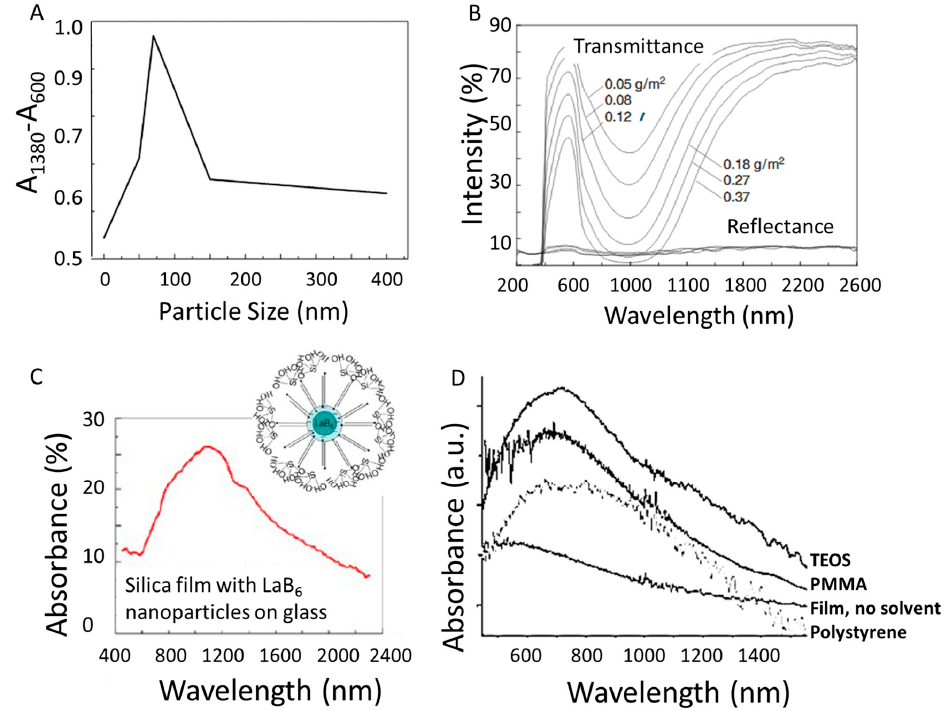
Figure 7. ( A ) Relative strength of absorption in composites containing LaB 6 particles of different sizes; 0 nm represents pure polymer without LaB 6 . (reprinted from [86]). ( B ) Transmittance and re fl ectance pro fi les of LaB 6 nanoparticle-dispersed acrylic coatings with different thicknesses on PET fi lms (reprinted from [87]). ( C ) Absorbance spectra of cetyltrimethyl ammonium bromide